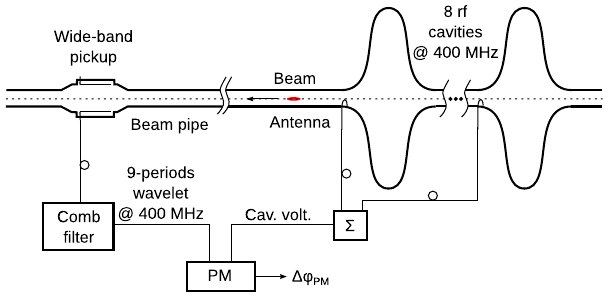
1. Simplified scheme of the synchronous phase measure- ment. A wavelet is generated from the wideband pickup signal and is compared in phase in the beam phase module with the vector sum of the voltages of the eight rf